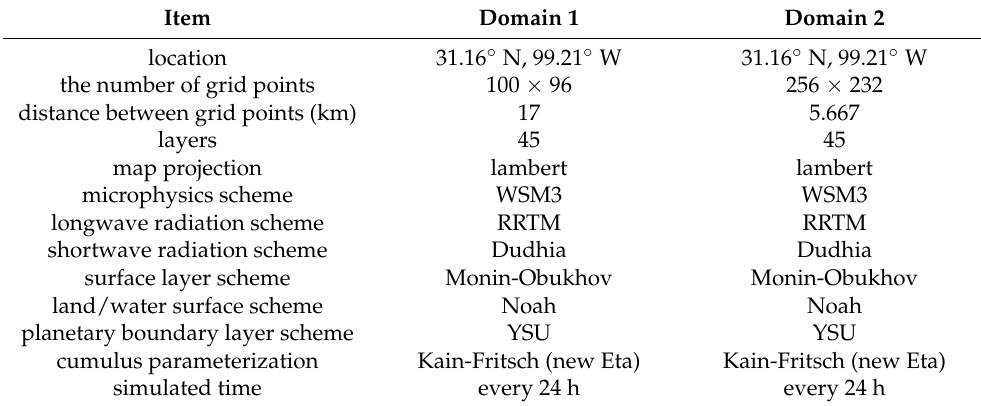
Table 2. Selection of scheme and parameters of the Weather Research and Forecasting (WRF) model. Item Domain